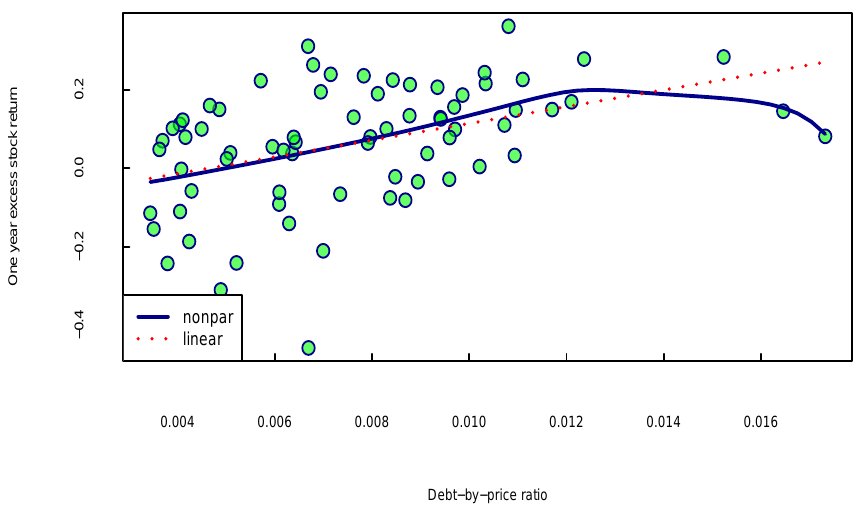
Figure 3. Risk-free benchmark. Relation between excess stock returns and debt-by-price ratio. Estimated nonparametric function ˆ m (dark blue line), linear model (dotted red line), observations (green balls). The sample period is